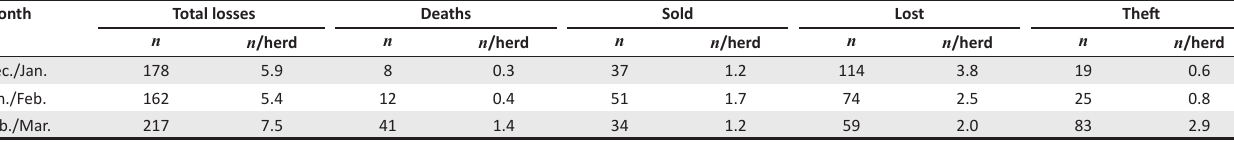
n n /herd n n /herd